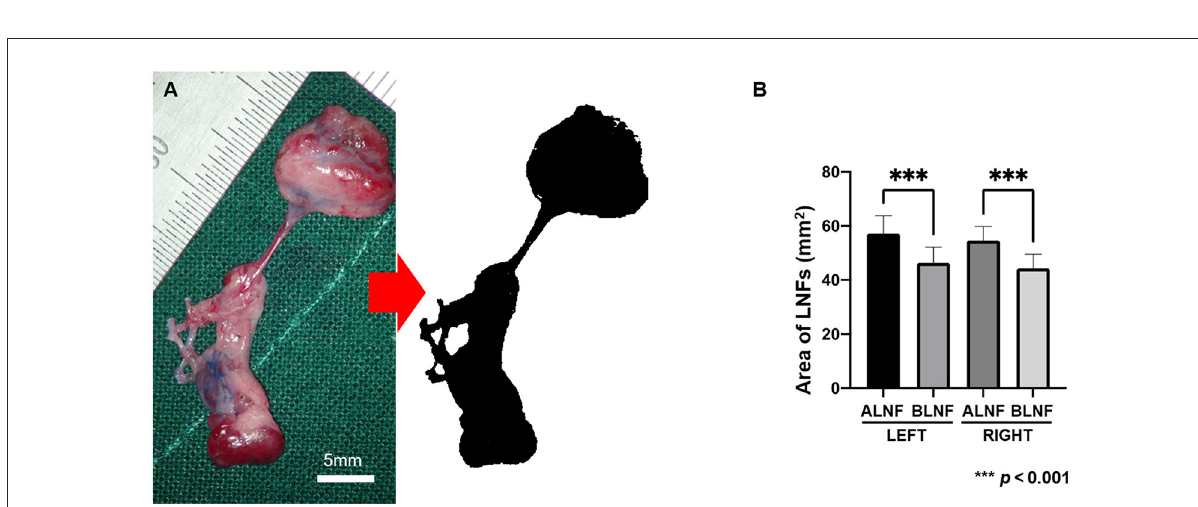
FIGURE4 (A) The harvested LNF tissue photographed under 4 × enlargements and the image processed to measure the area (black area). The scale bar is 5mm. (B) Area of LNFs on each side. In this bar chart, the difference in area between the ipsilateral ALNF and BLNF is compared; the area of the same type of flap on different sides is compared. *** indicate the p-value between each group ( p <